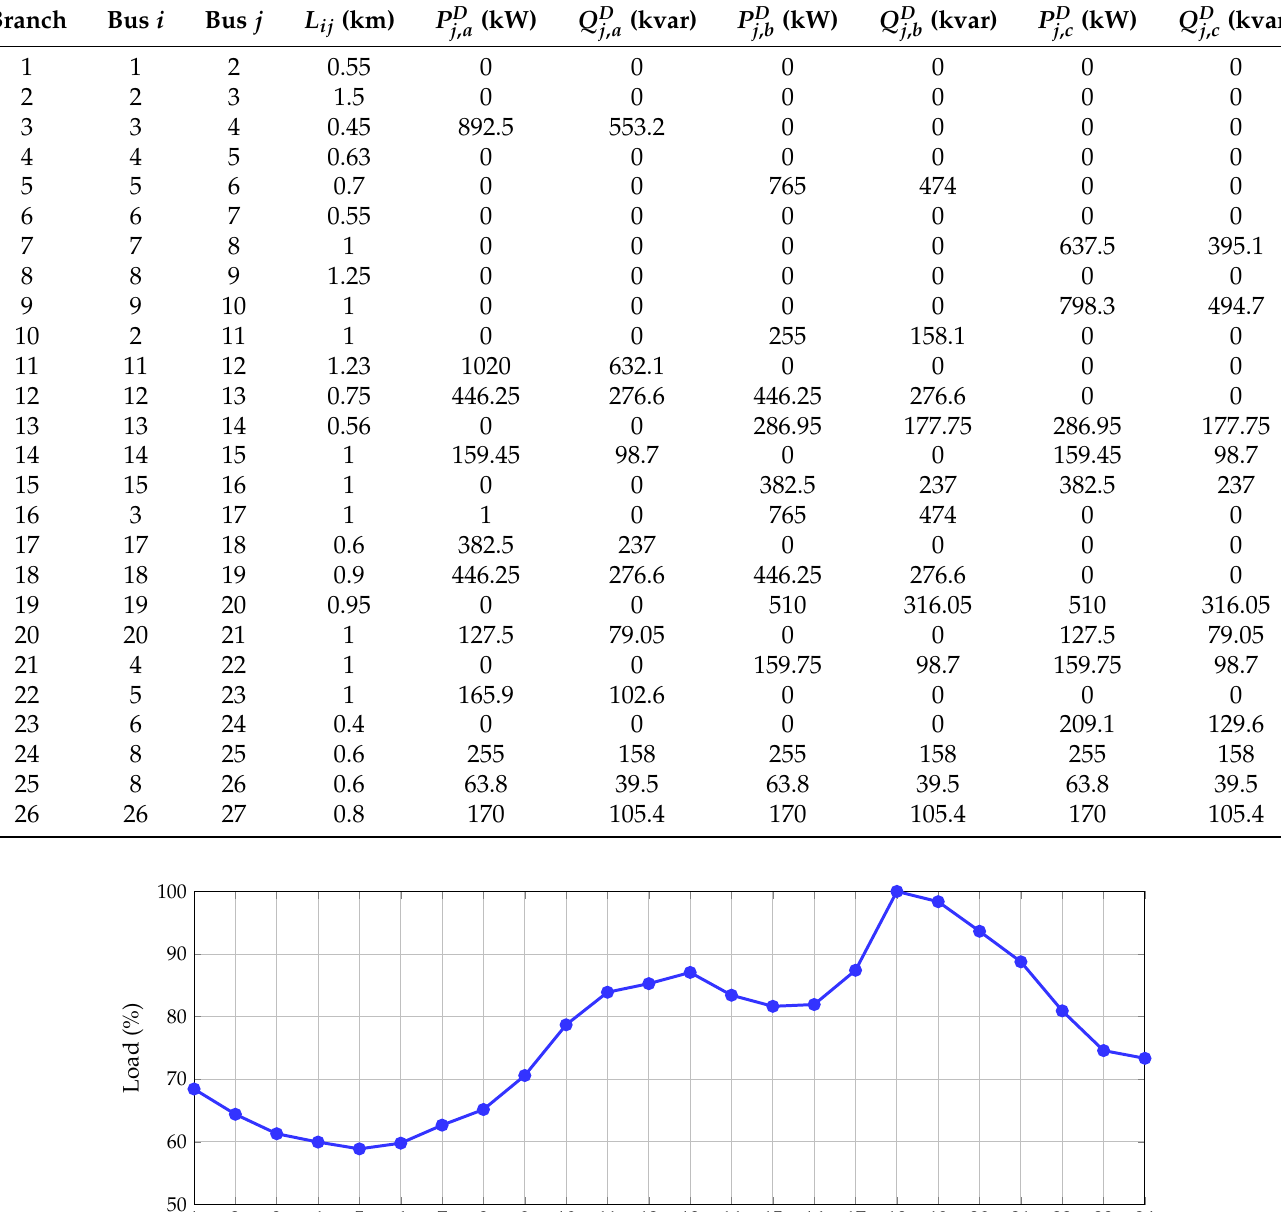
Table 9. Parametric information of the 27-bus test feeder for the unbalanced case.